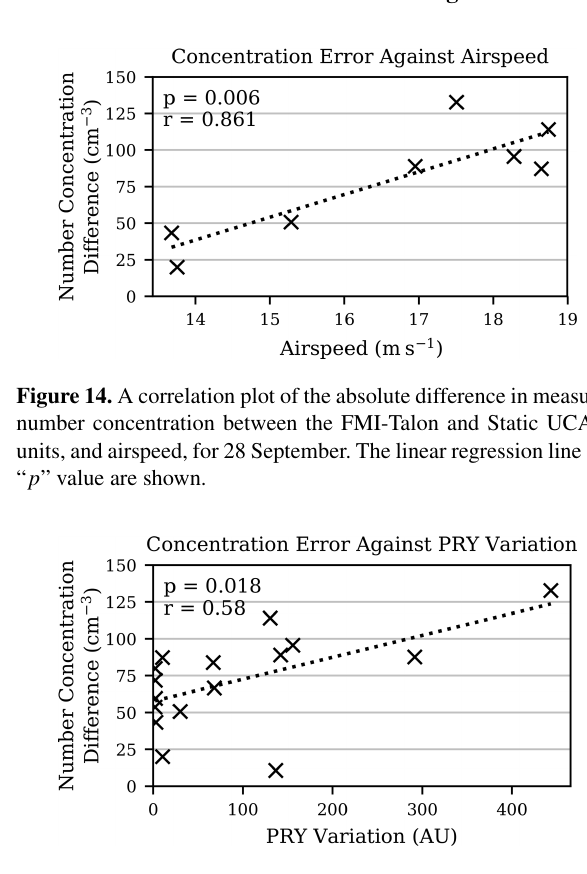
Figure 13. A plot of the two instrument response curves – that is, 12-bit ADC output versus scattering cross section diameter – from calibration data collected before and after the campaign.